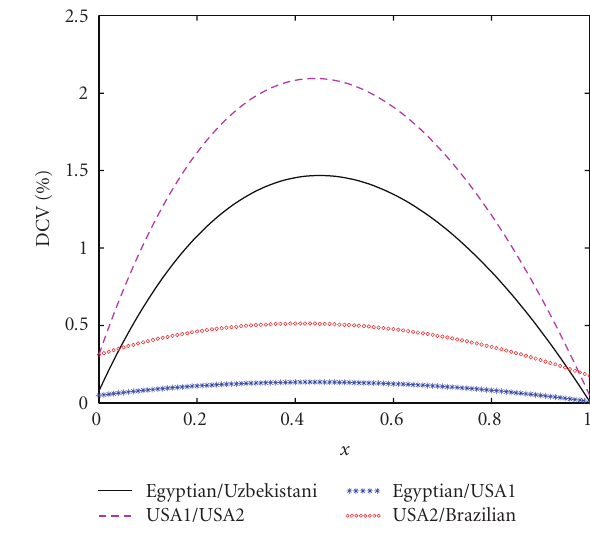
Figure 13: DCV% dependence to x